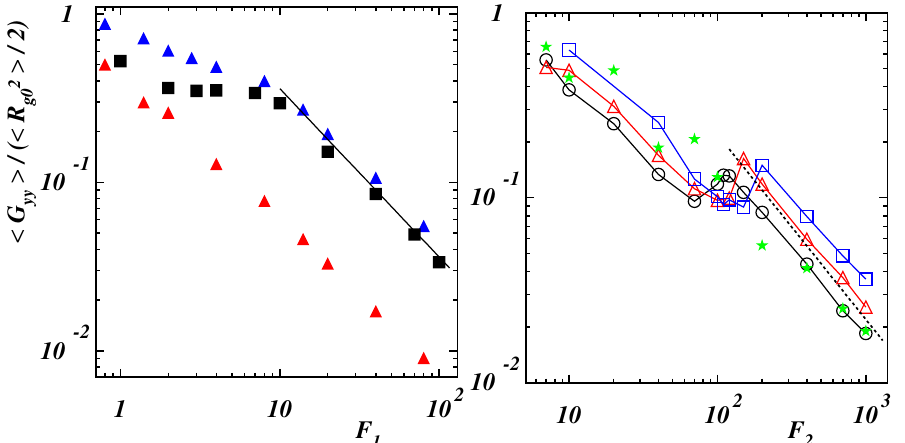
Figure 8. ( Left panel) Radius of gyration tensor component along the y -direction with respect to the equilibrium value as a function of the dimensionless force F 1 = NFr 0 / ( k B T ) for L p / L = 0.1 (blue filled triangles), 0.2 (black filled squares) with (cid:101) / ( k B T ) = 2, and for L p / L = 0.1 (red filled triangles) with (cid:101) / ( k B T ) = 0.25. The full line has slope − 1. ( Right panel) Radius of gyration tensor component along the y -direction with respect to the equilibrium value as a function of the dimensionless force F 2 = NFL p / ( k B T ) for L p / L = 0.4 (black open circles), 0.6 (red open triangles), 0.8 (blue open squares), and 2 (green filled stars) with (cid:101) / ( k B T ) = 2. The dashed line has slope −